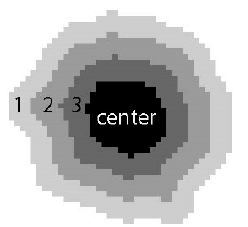
Figure A1. Radial intensity features. Example of the 3 rings with a width of 4 pixels and the center region. In each of these four regions, the mean and standard deviation of the intensity are computed.